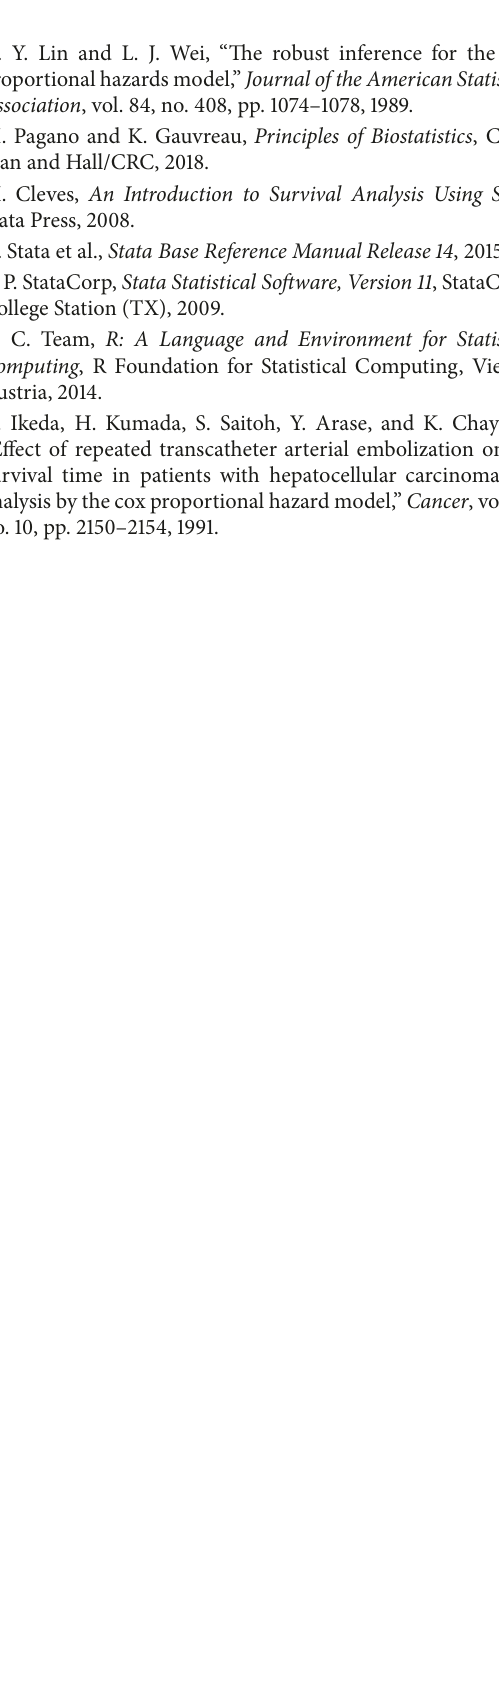
The life table method calculates survival